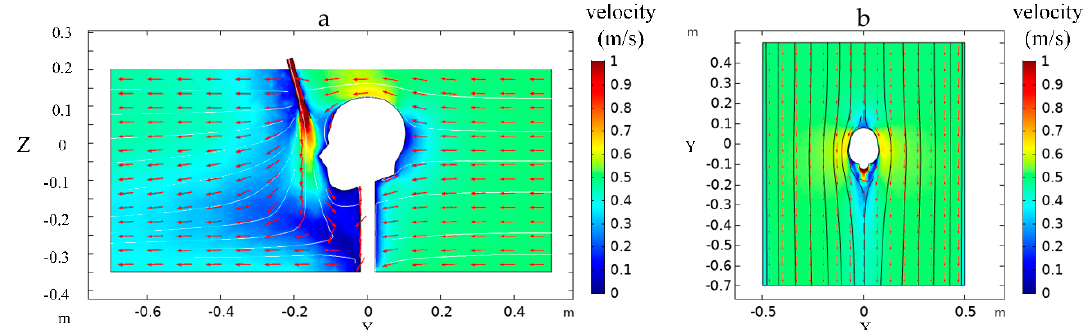
Figure 6. ( a ) Side view of air velocity at X = 0 m section. ( b ) Top view of air velocity at Z = 0.05 m section.